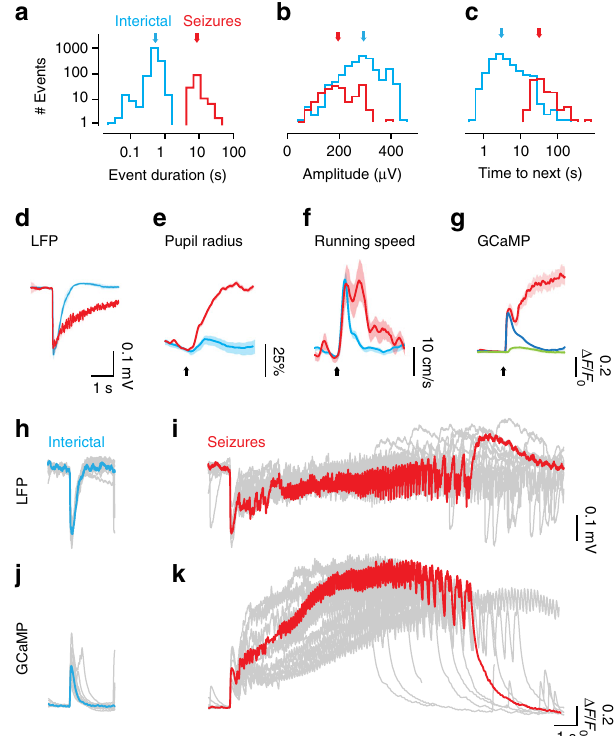
Fig. 2 Neural and behavioral signatures of seizures and interictal events. a Distribution of the duration of interictal events ( blue ) and seizures ( red ). Arrows indicate the medians of each distribution. b Distribution of event amplitudes, measured as the peak of the initial LFP negative event. c Distribution of inter-event intervals (time to next event). d LFP waveform following the onset of interictal events ( blue ) and seizures ( red ), averaged across all events in fi ve mice. e Change in pupil radius triggered on the onset of interictal events ( blue ) and seizures ( red ), for one representative animal. Arrow indicates event onset. f Same, for running speed. g Time courses of GCaMP activity in the same animal, averaged over area V1, during interictal events ( blue ) and seizures ( red ). Green trace shows response to visual stimuli for comparison. h LFP waveform of representative interictal events in one experiment. Blue trace highlights a single event. i Same as h , for seizures in the same experiment, with a highlighted trace in red . j , k GCaMP activity averaged over visual cortex during the example events in